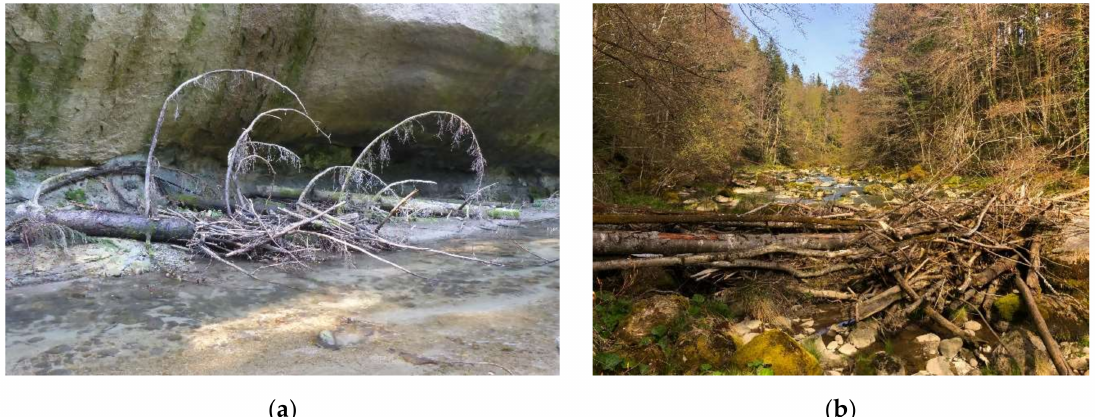
Figure 2. ( a ) Example of a LWS placed parallel to the flow direction that is hydraulically and morphologically ineffective at low discharges; Scherlibach stream; Photo: Courtesy of W. Dönni. ( b ) Example of naturally retained and piled up LW; Töss River; Photo: Courtesy of L.